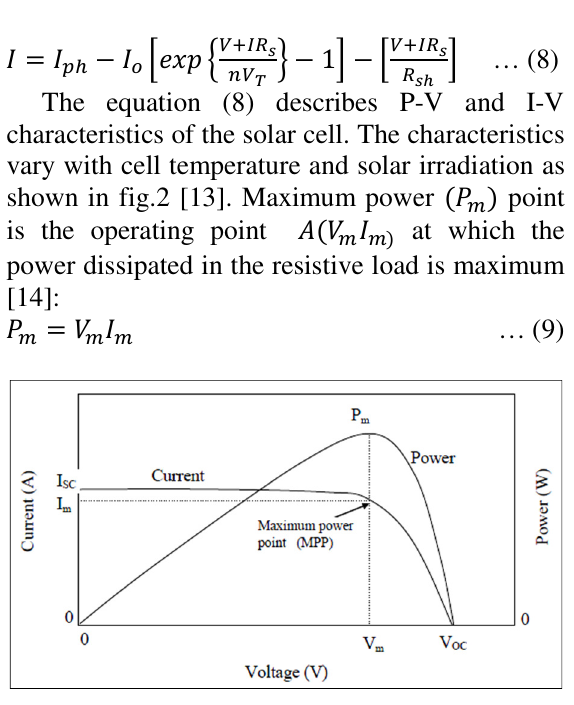
Parameter specification of MSX-60 module( j , k = jlm(cid:19) fgh/i